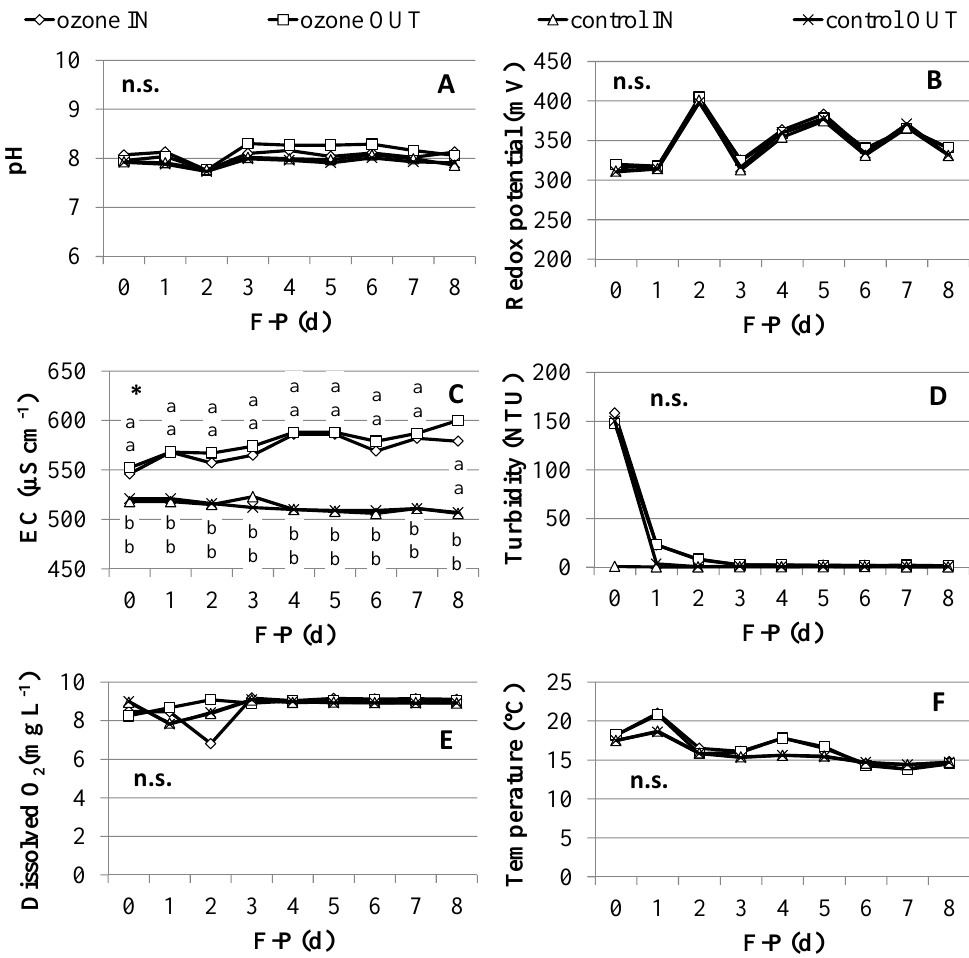
Figure 1. Influence of ozone treatment on the main water physical and chemical parameters during the forcing process (F-P): pH ( A ), redox potential ( B ), electrical conductivity ( C ), turbidity ( D ), dissolved O 2 ( E ) and temperature ( F ). Within each parameter, different letters indicate significant differences for each monitoring day according to the Tukey’s Honest Significant Difference test at p < 0.05.